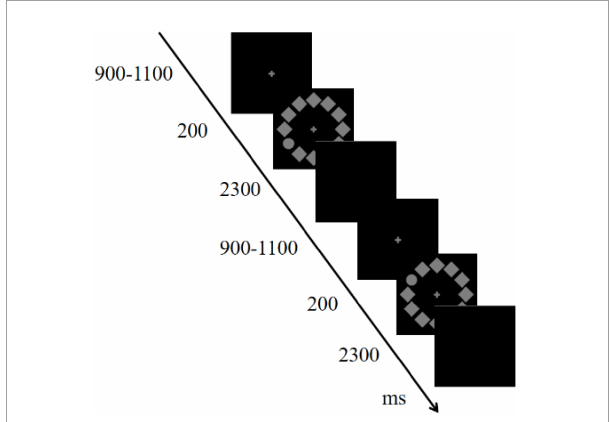
FIGURE1 Sequence of the stimulus-response compatibility visual search